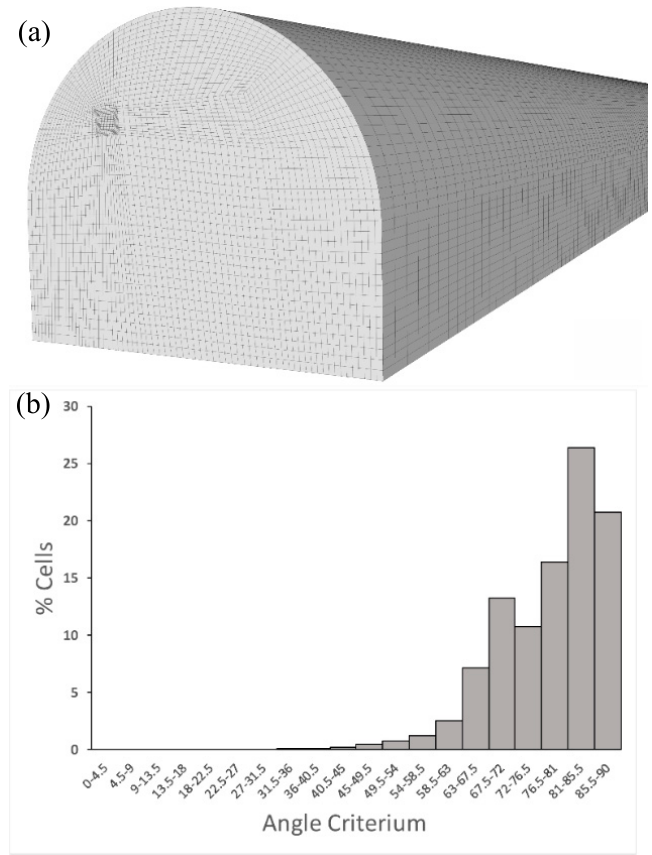
Figure 4. ( a ) Mesh and ( b ) mesh quality in terms of angle criterion.